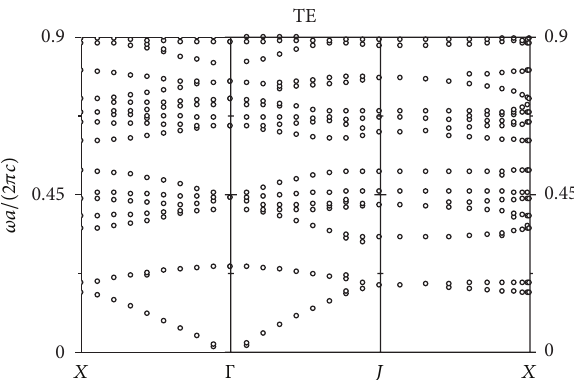
Figure 12: The TE mode photonic bands of two-dimensional pho- tonic crystals made by GaAs pillars in air with graphite lattice.